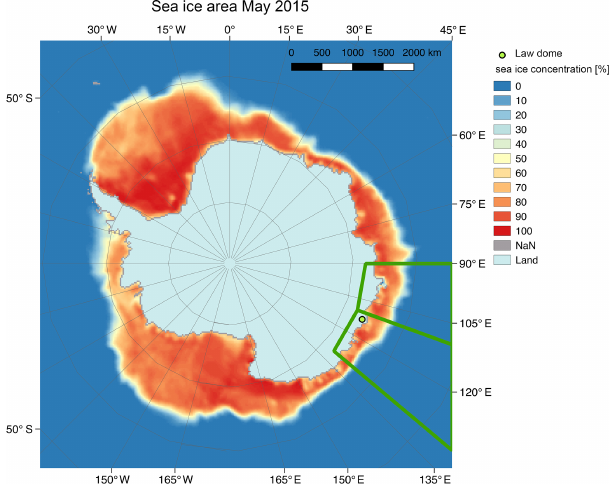
Figure 2. Antarctic sectors used for evaluating sea ice trends. Two sectors (90–110 ◦ E and 110–130 ◦ E) adjacent to Law Dome have been isolated and used to calculate past sea ice area. The image shows and example of sea ice area for the month of May 2015 given as sea ice concentration (%) per grid